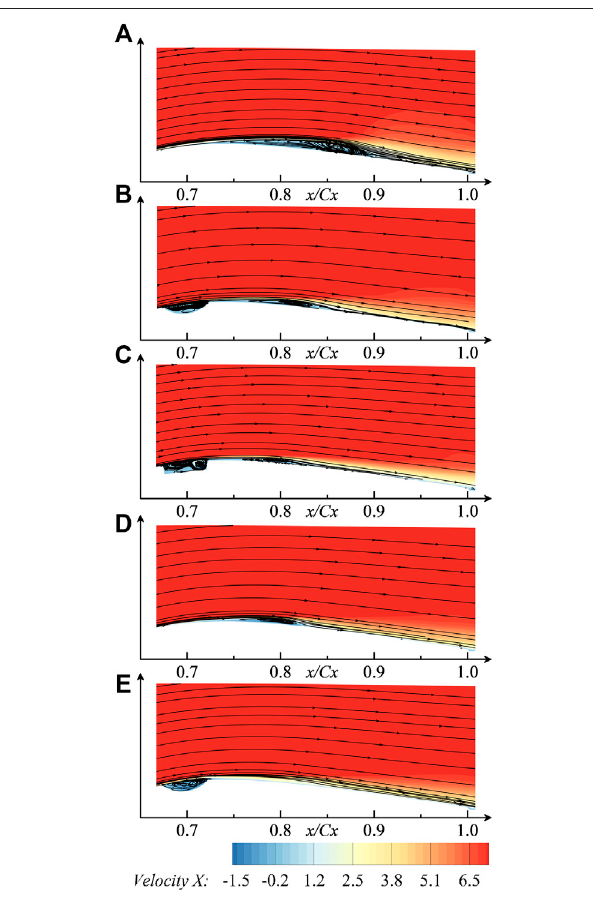
FIGURE 6 | Contours of time- and spanwise-averaged streamwise velocity: (A) baseline; (B) U-groove; (C) rectangular groove; (D) DE plane; (E) DC plane.